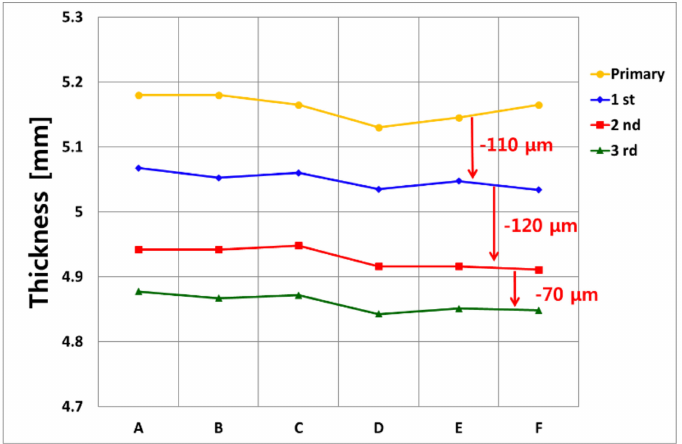
Figure 9. The thickness measurement result of the manual ultrasonic testing (UT) at room temperature.